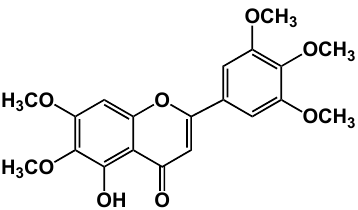
Figure 1. Chemical structure of Umuhengerin.